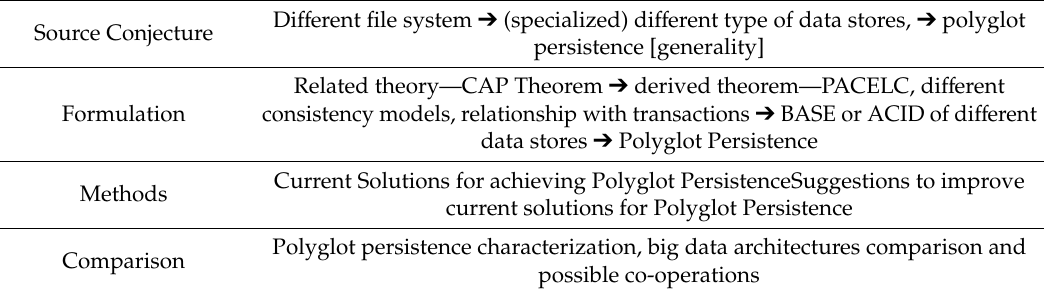
Table 1. The sequence of the Steps leading to Polyglot Persistence